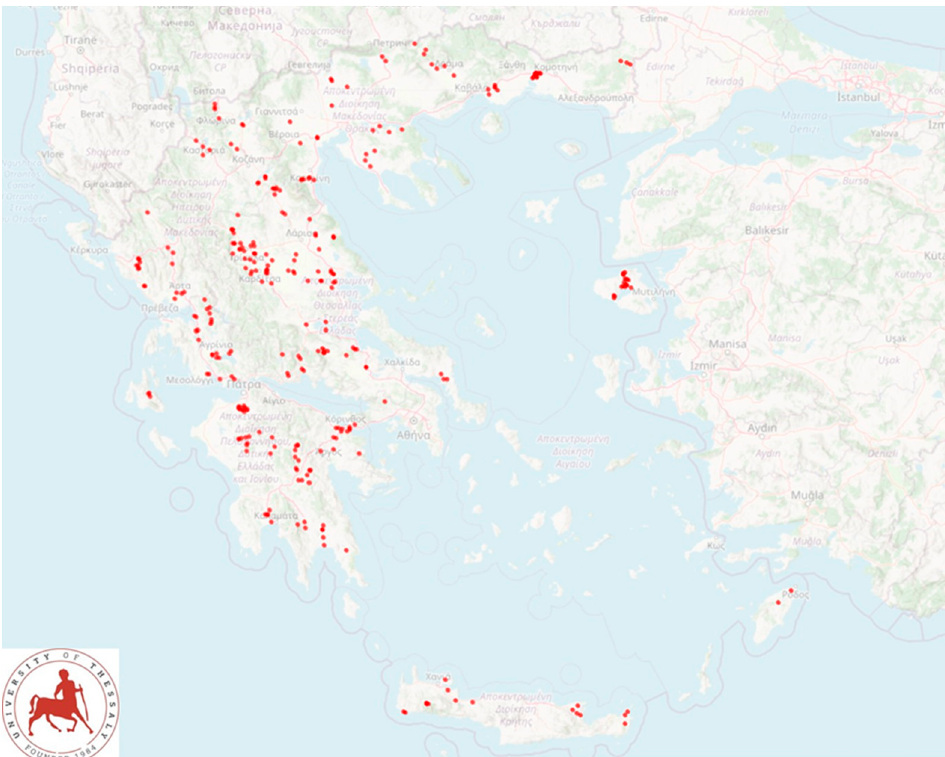
Figure 1. Locations of 444 small ruminant farms around Greece that were visited for bulk-tank milk sampling.